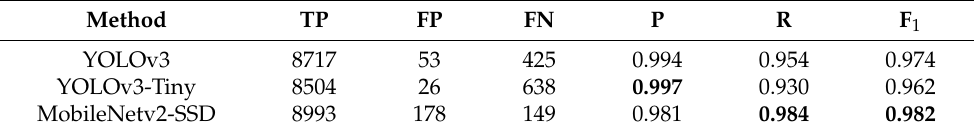
Table 6. Evaluation of the CNN-based object detection frameworks using the enhanced im- age datasets.